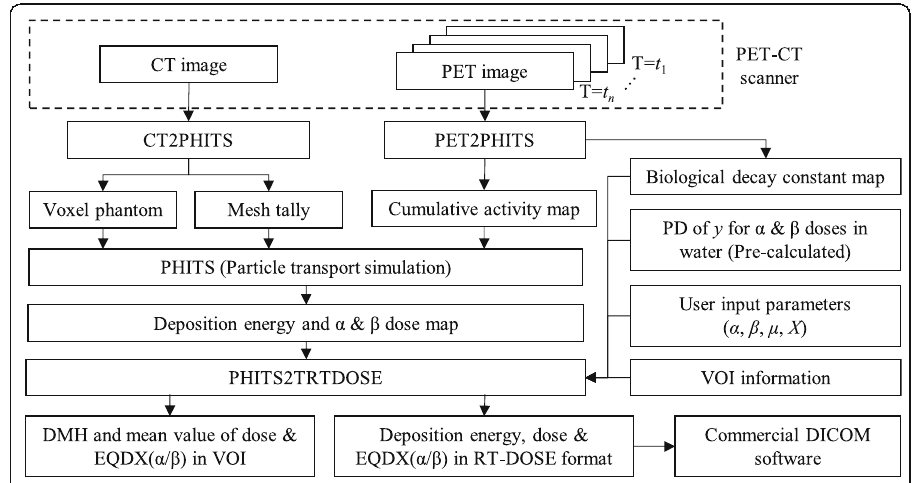
Fig. 1 Flowchart of the individual dosimetry system based on